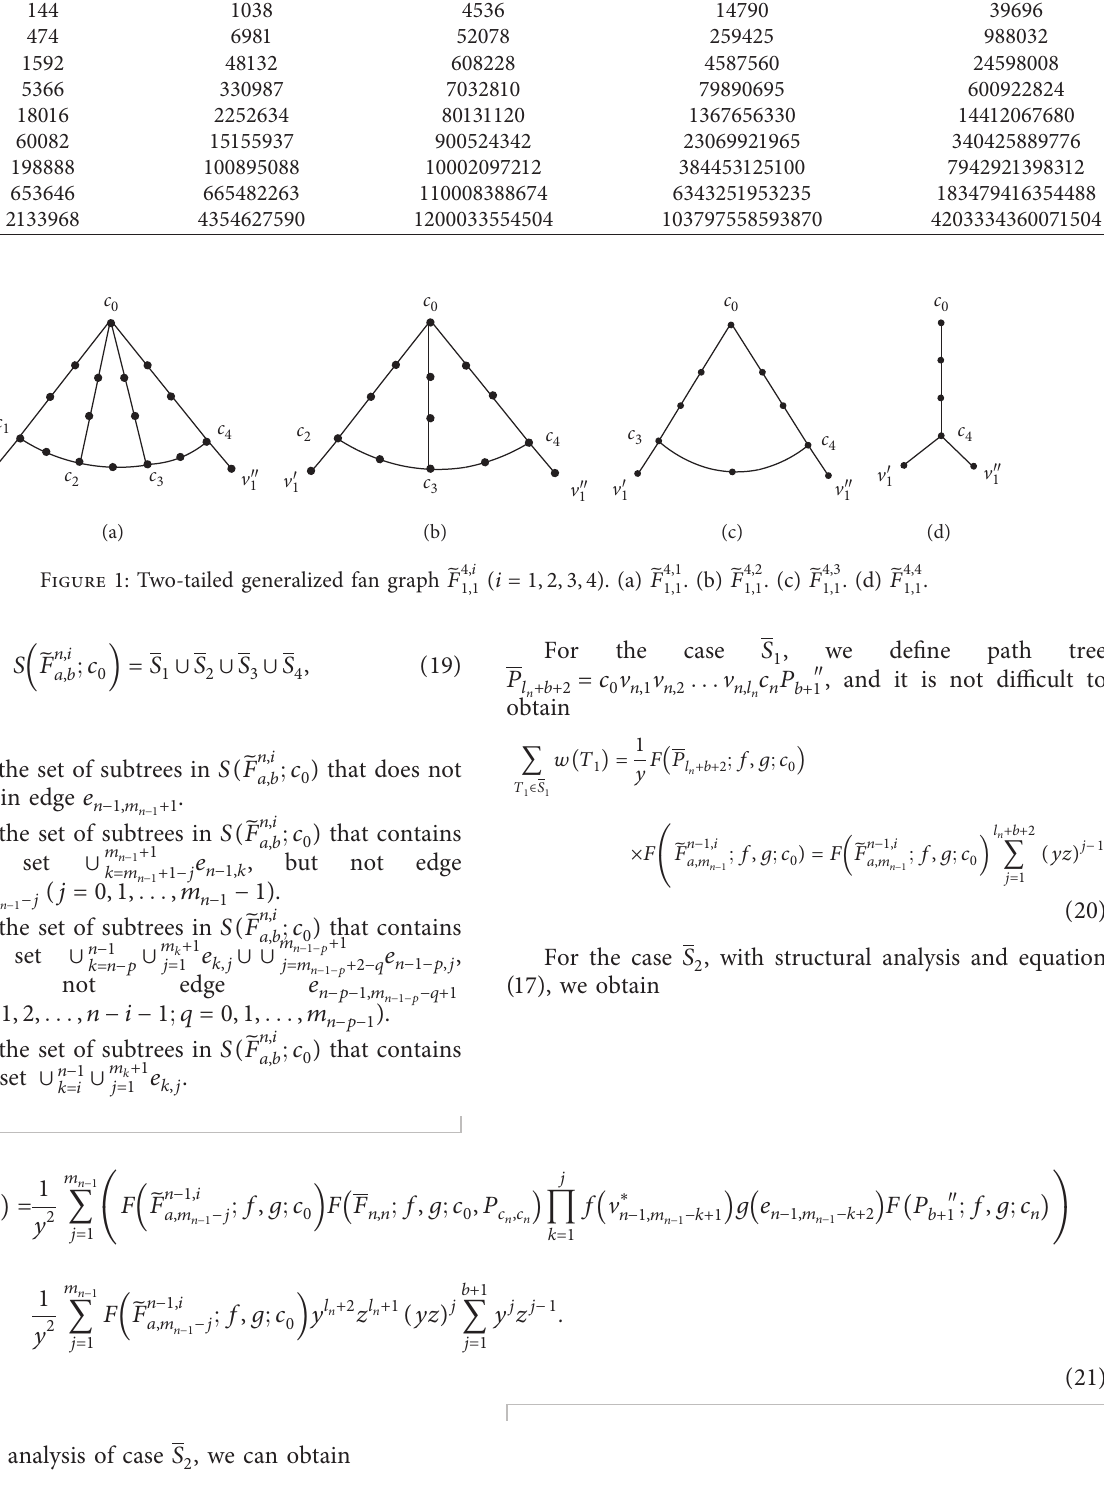
Table 1: The subtree number index STN ( B n STN ( B n, 1